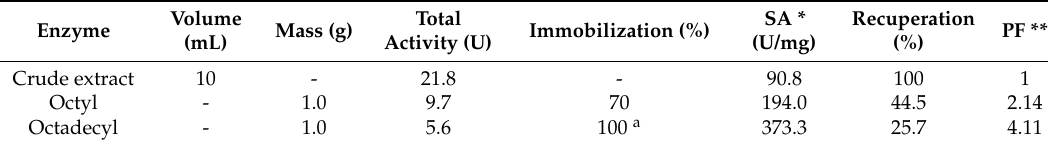
Table 2. Purification of two lipases from F. verticillioides